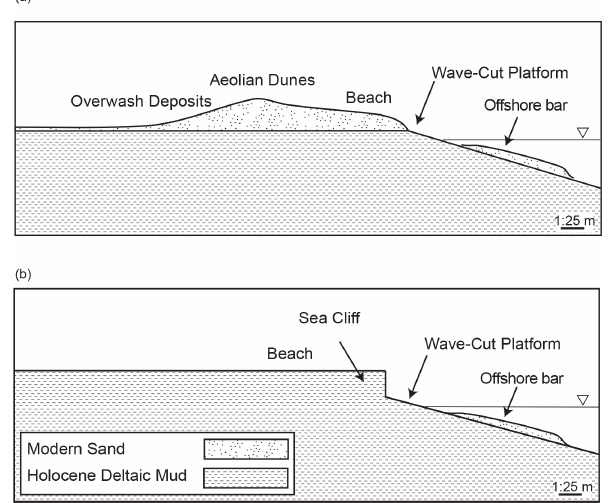
Figure 3. (a) Generalized cross section of the shore platform. (b) Generalized cross section of the shore platform and sea cliff system. ∼ 1 : 25m vertical